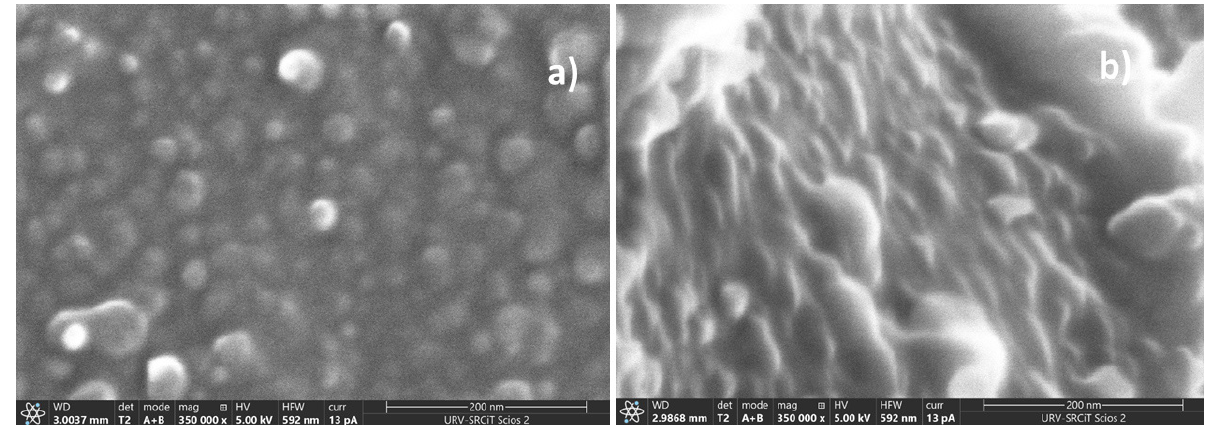
Figure 3. FESEM images of membrane cross-sections of: CP40 ( a ) and CP40-oriented ( b ).